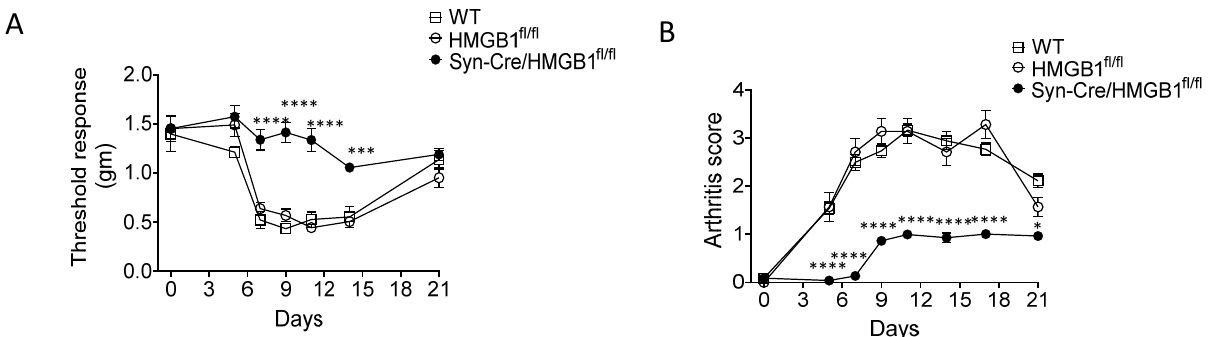
Figure 4. Ablation of neuronal HMGB1 reduces joint inflammation and cartilage destruction, while improving hyperalgesia in murine collagen antibody-induced arthritis. Polyarthritis was induced by administration of anti-collagen antibodies in mice. Wild type (WT) and HMGB1 fl/fl control mice develop increased mechanical hypersensitivity ( A ) and polyarthritis ( B ). A significantly delayed onset and reduced severity of polyarthritis are observed in HMGB1 knock out (Syn-Cre/HMGB1 fl/fl ) mice. This is accompanied by a marked reduction in mechanical hyperalgesia. (Syn-Cre/HMGB1 fl/fl versus HMGB1 fl/fl group: * p < 0.05, *** p < 0.001, **** p < 0.0001. Reproduced from Yang et al. [27] ).